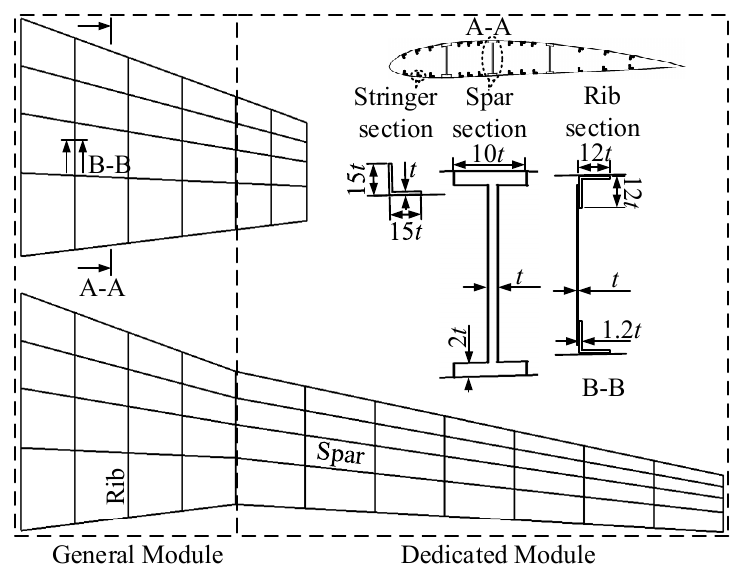
Figure 6. Schematic diagram of the wing structure.